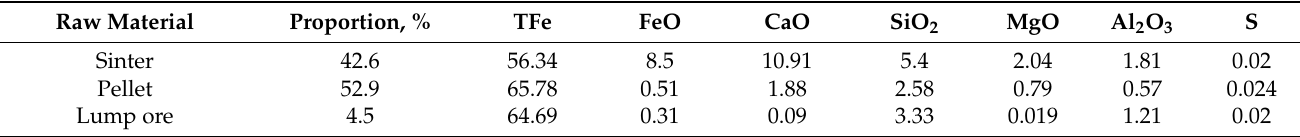
Table 1. Raw material composition (mass